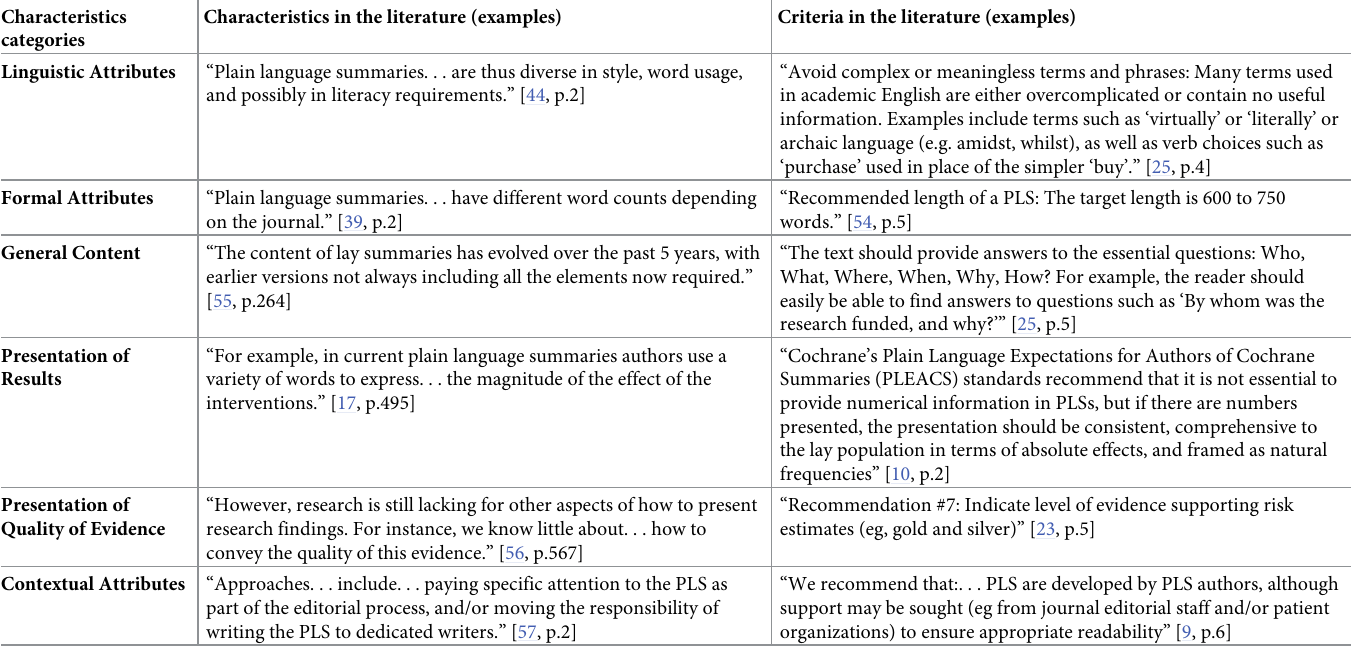
Table 2. Characteristics categories with matched exemplary text passages of characteristics and